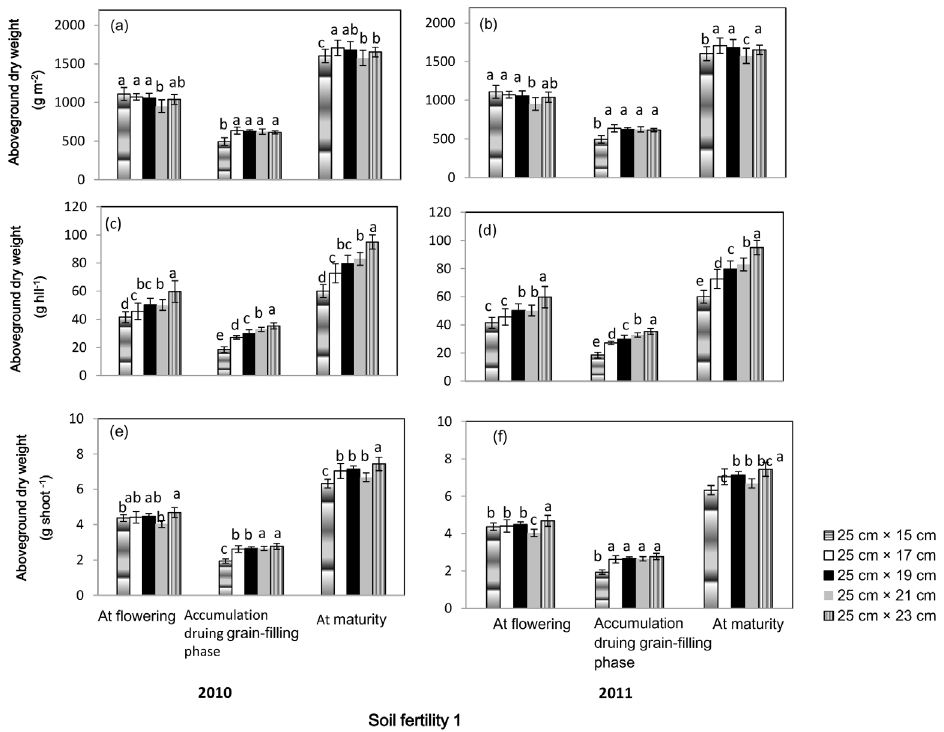
Figure 3. Aboveground dry weight at flowering and maturity, and dry weight accumulation during grain-filling phase of a high- yielding hybrid rice variety Nei2you6 grown at five seeding spacings in soil fertility 1 at the China National Rice Research Institute, Zhejiang Province, China, in 2010 and 2011. Aboveground dry weight was calculated as dry weight per m 2 (a, b), dry weight per hill (c, d), and dry weight per shoot (e, f). Dry weight per shoot was the ratio of dry weight per hill to productive tiller number per hill.